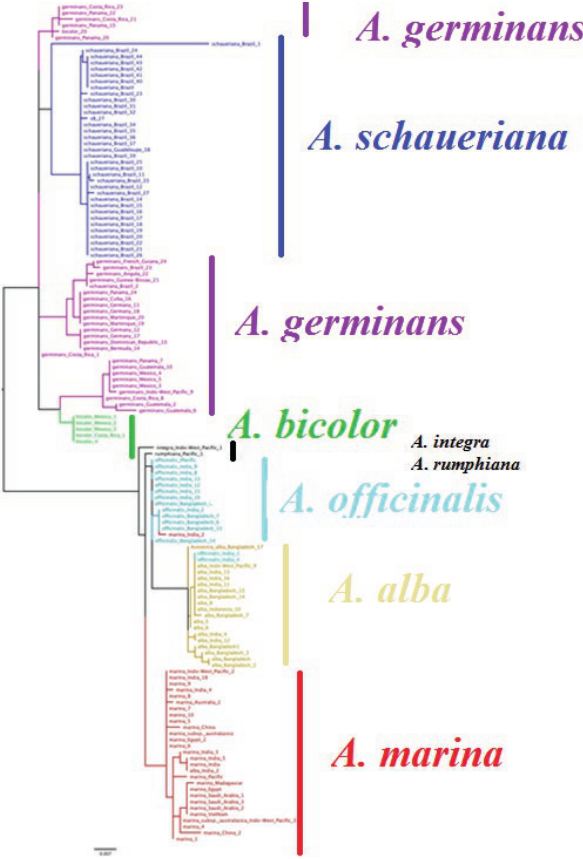
Figure 8. ML Phylogenetic tree of Avicennia species based on ITS